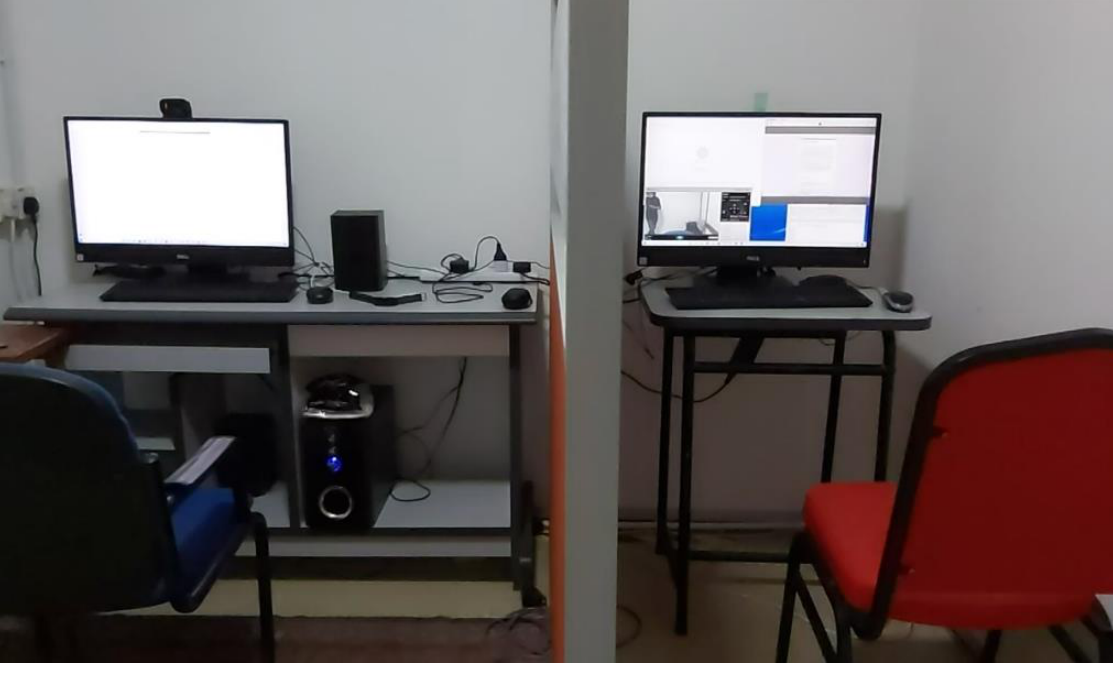
Figure 12. Data collection lab